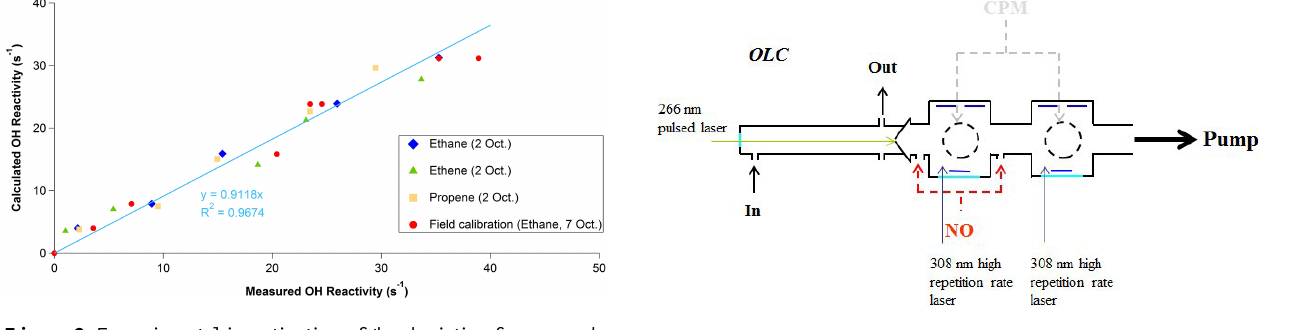
Figure 3. Schematic of the UL-FAGE instrument, as configured for OH reactivity